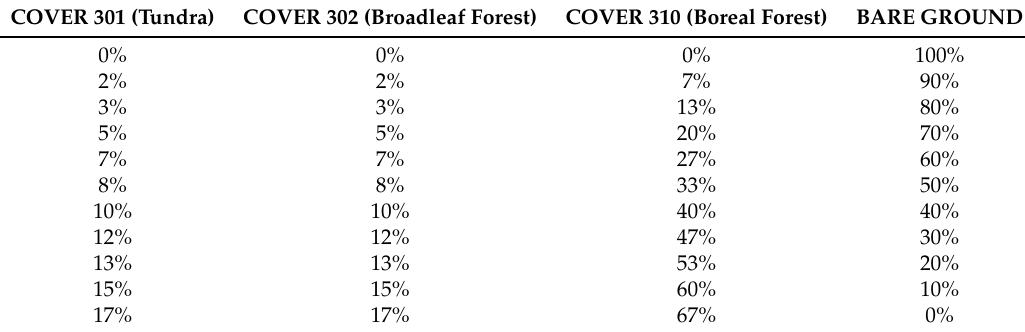
Table 2. List of ECOCLIMAP II cover fractions for each